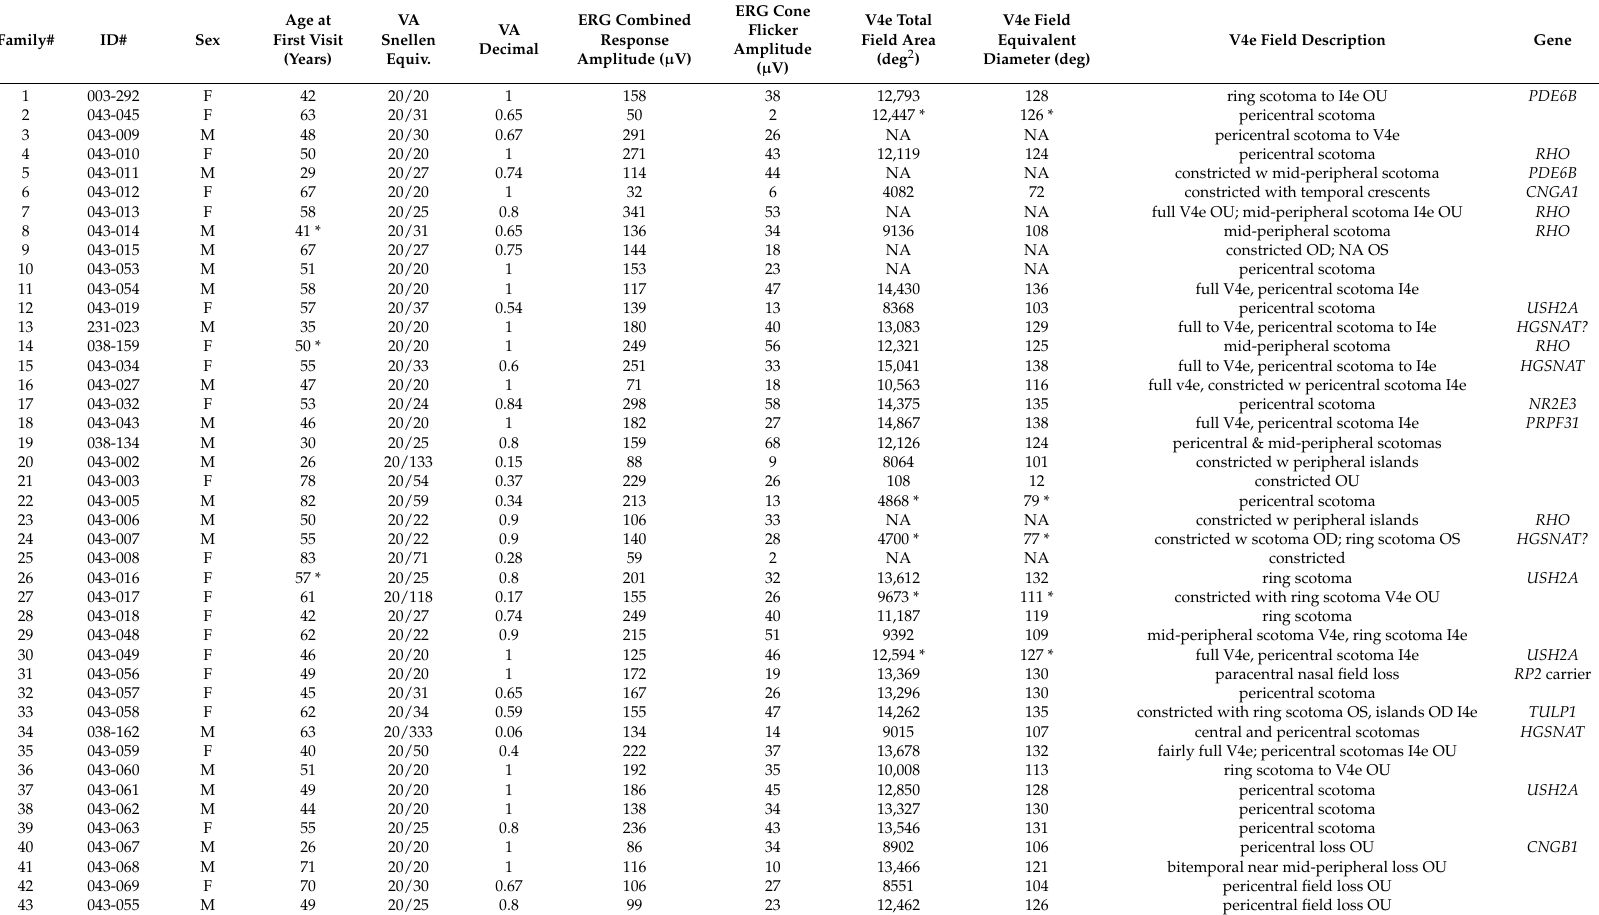
Table 1. Baseline clinical characteristics of cohort probands. Further details regarding genes (last column) are provided in Table